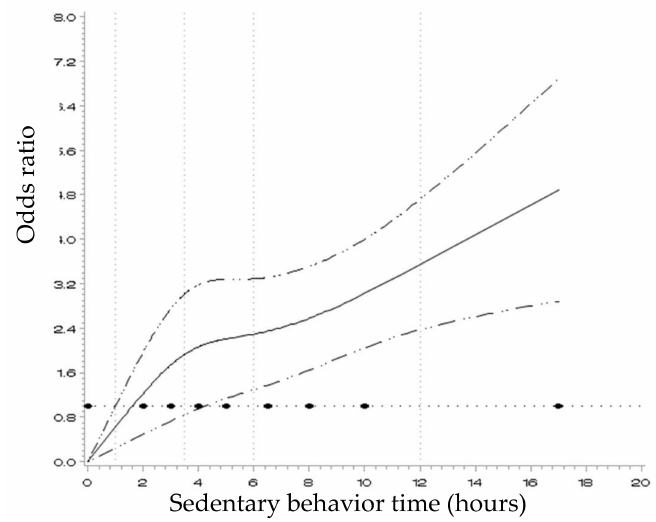
Figure 1. Natural cubic spline fitting of the association between sedentary behavior time and the risk of CHD. The horizontal line represents the reference value of OR = 1.0. The solid curve represents ORs for the risk of CHD and the dashed curves represent the 95%